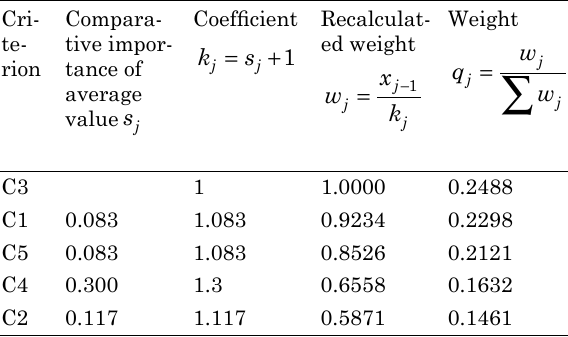
Table 4. Final results of SWARA method in